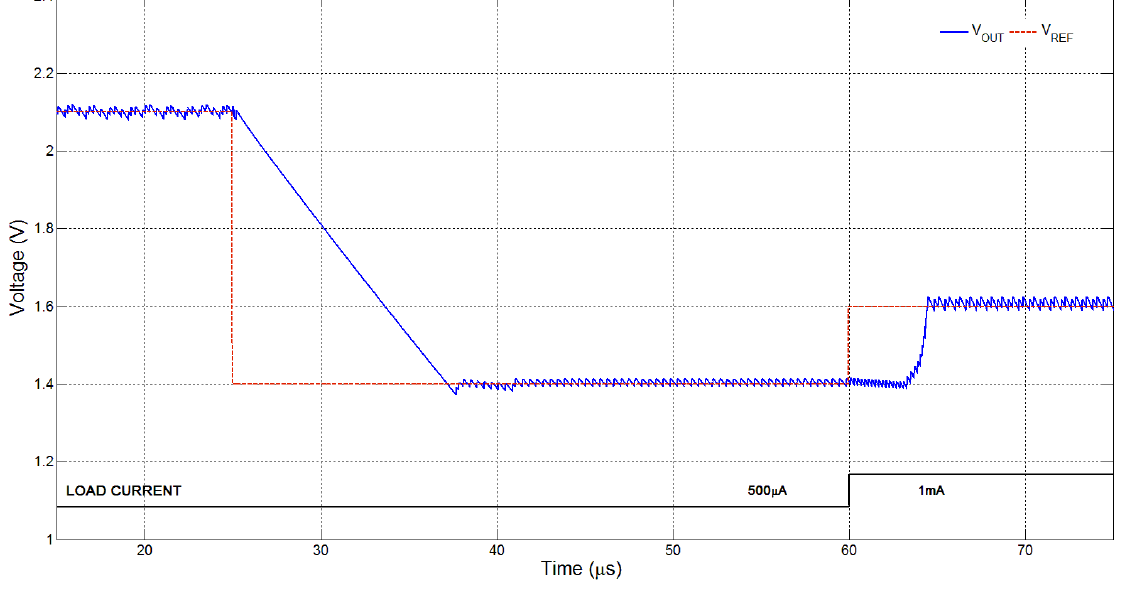
for a load of 10 µ REF